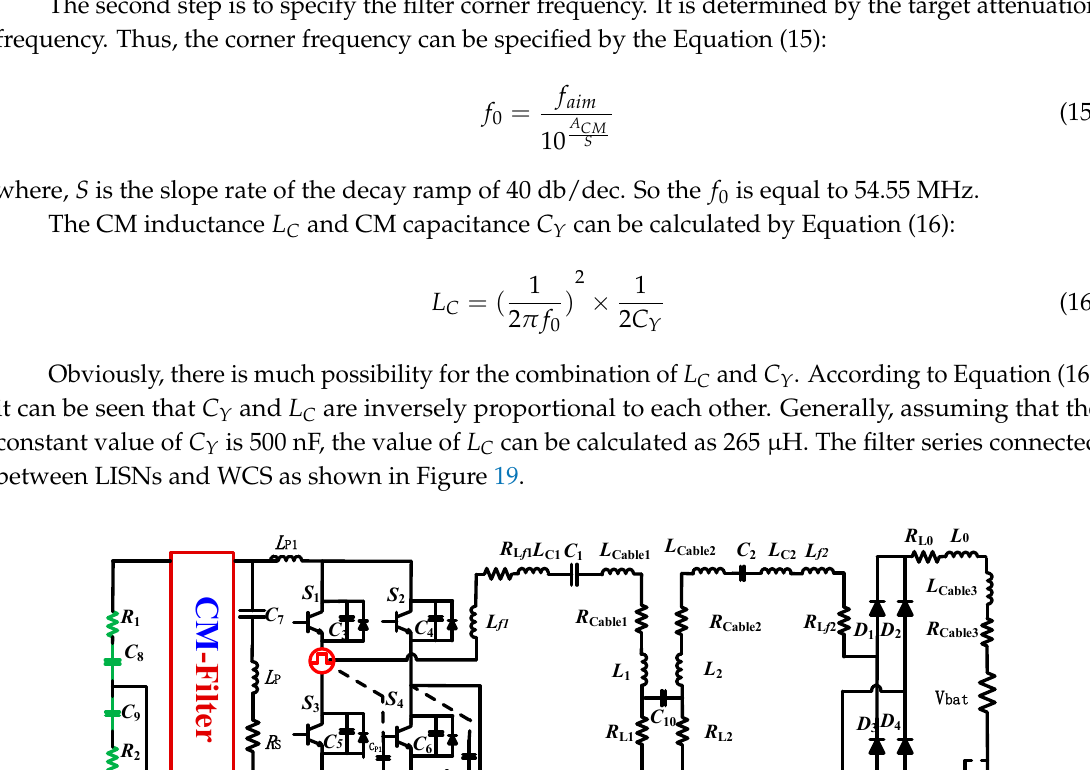
( b ) Figure 20. EMI filters ( a ) Comparison of different topologies; ( b ) Designed CL filter. From Figure 20, by adding the CL topology CM filter, the conducted voltage in the frequency 150 kHz–108 MHz can be decreased to below the limits of standard GB/T 18655-AVE level 3 and the harmonic wave is obviously suppressed. In addition, it is unnecessary to design DM filters.